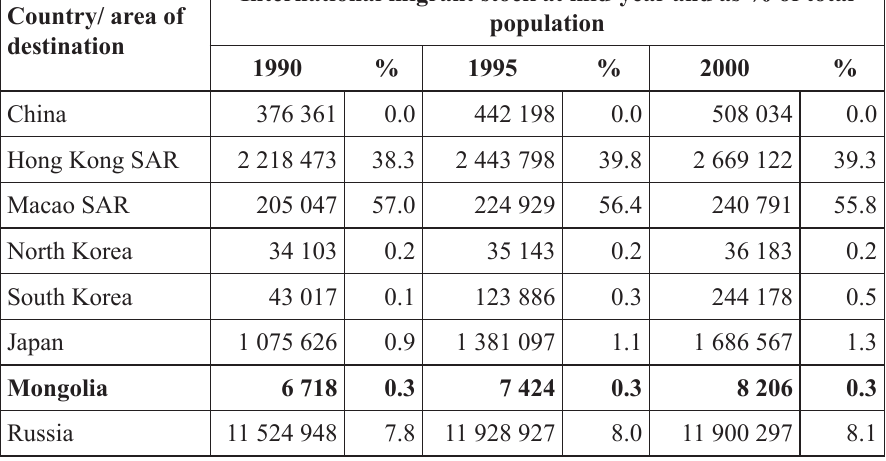
Table 1. International migrant stock at midyear and as a proportion of total population in Mongolia and other Northeast Asian countries/areas Country/ area of